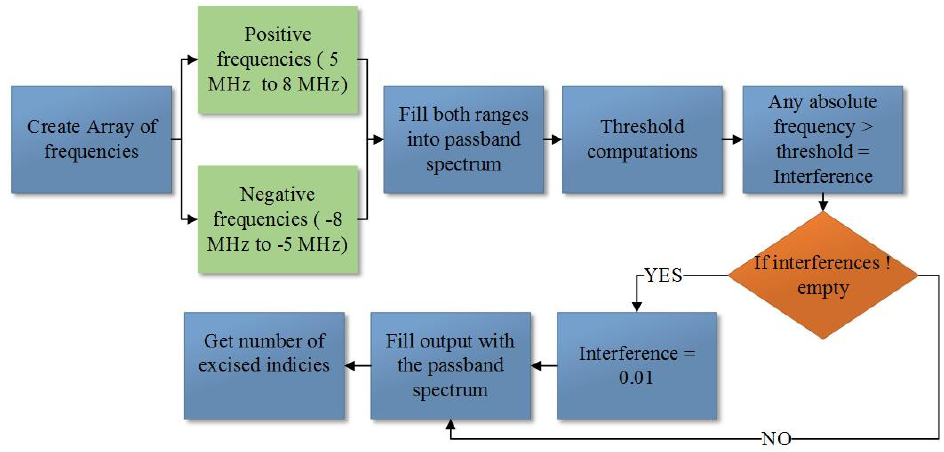
Figure 14. Flowchart of the interference suppression algorithm